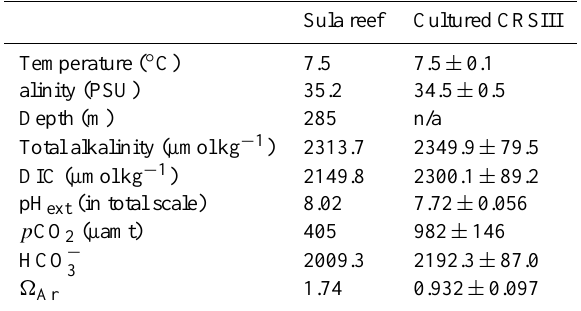
Table 1. Summarized environmental and culturing conditions from Form and Riebesell (2012) applicable to the specimens and skeletal regions analysed for skeletal boron isotopic